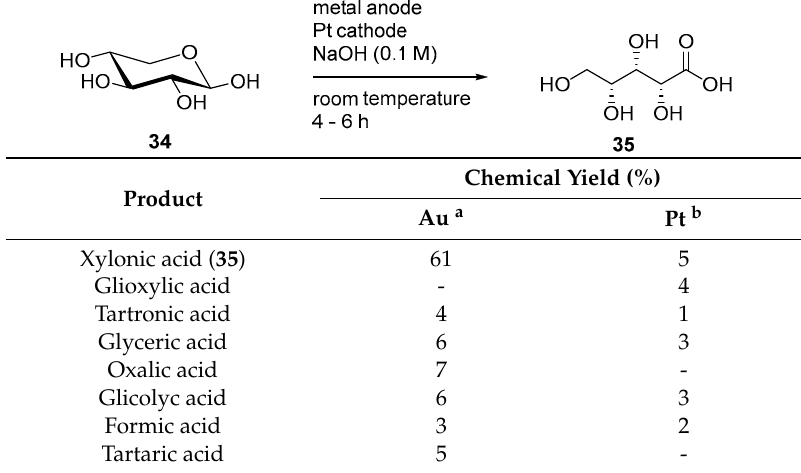
Chronoamperometry carried out for a: 6 h; b: 4 h.